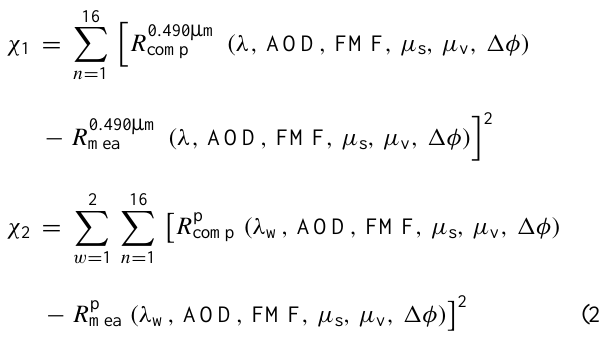
adjusted Total AOD can be retrieved using the FMF. The accuracy of the FMF can be